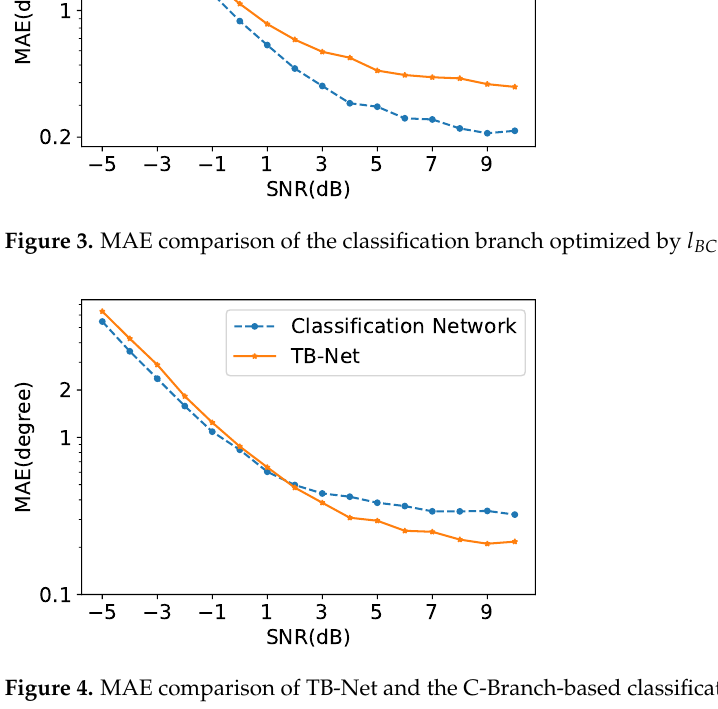
Figure 4. MAE comparison of TB-Net and the C-Branch-based classification network.